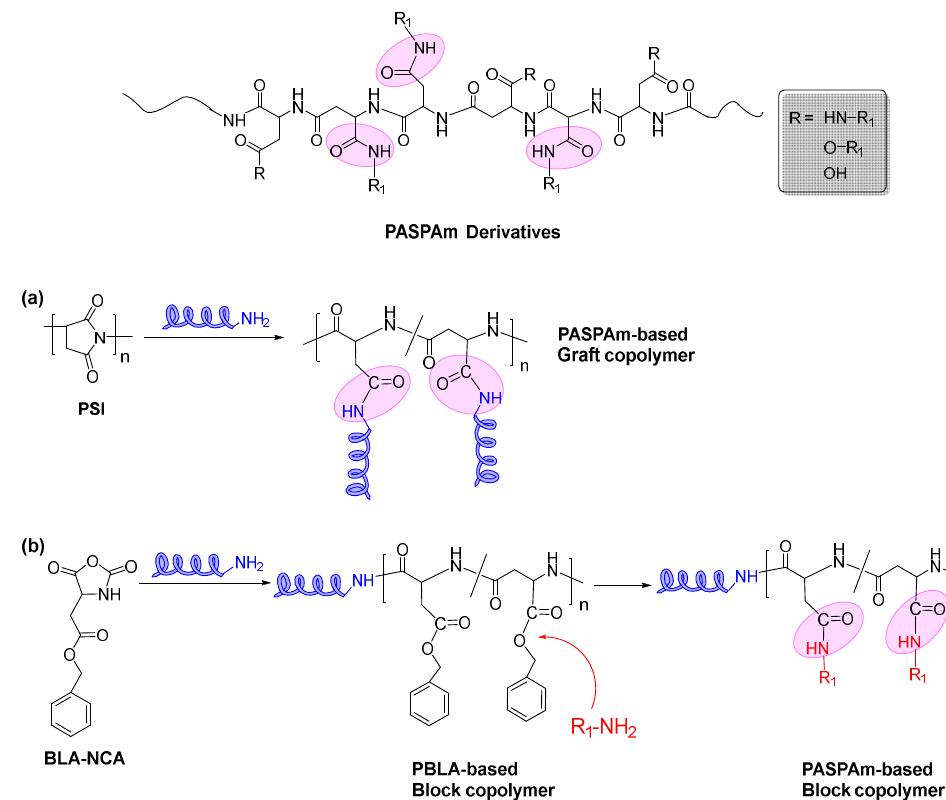
Figure 1. The synthetic pathways of PASPAm-based ( a ) graft copolymers and ( b ) block copolymers.